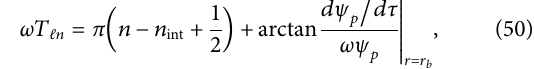
section. Due to the low values of the sound speed in the subsurface layers, the radial wavenumber of low-degree p-modes is much larger than the horizontal wavenumber. Therefore the radial eigenfunctions are expected to depend on the oscillation frequency ω only, but not on the degree ℓ .